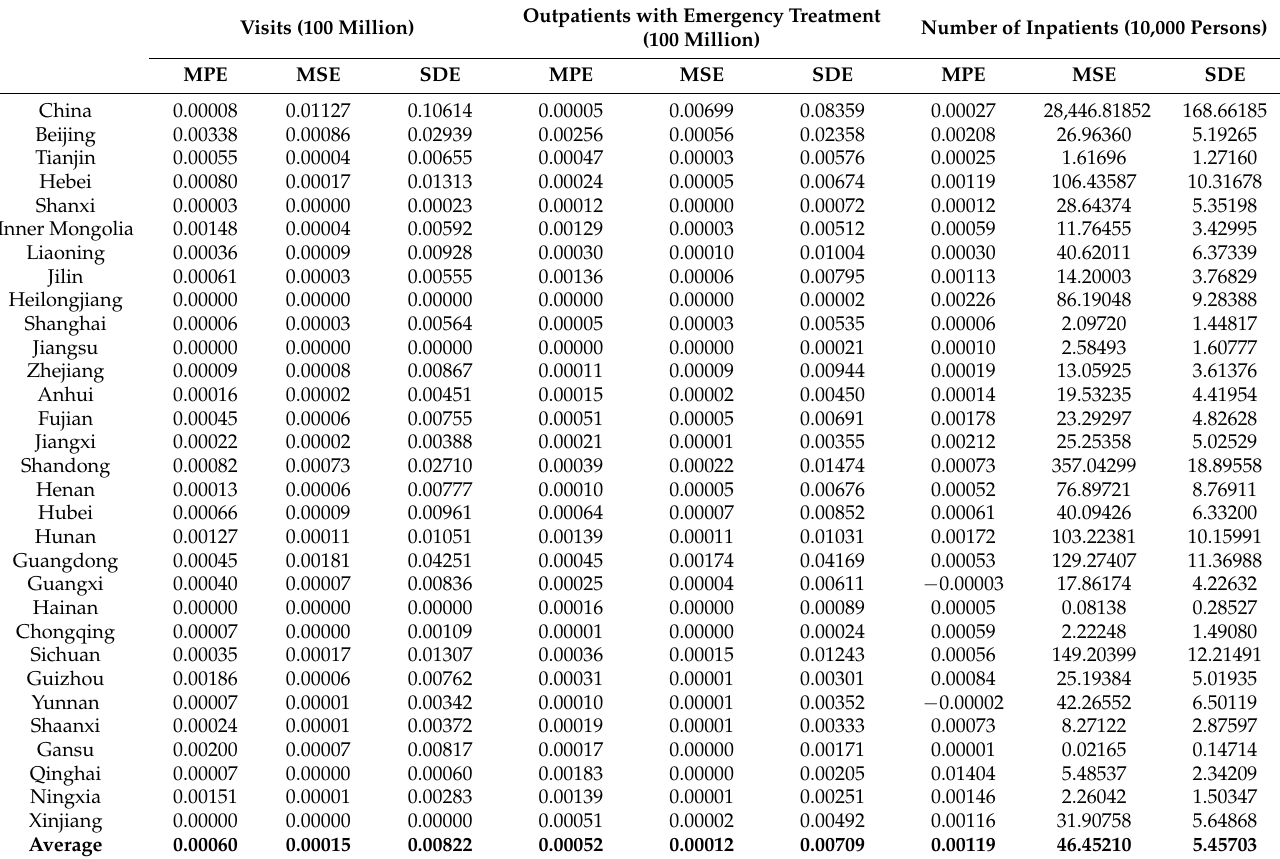
Table 5. The First Part of Forecasting performance of LS-SVM-FM